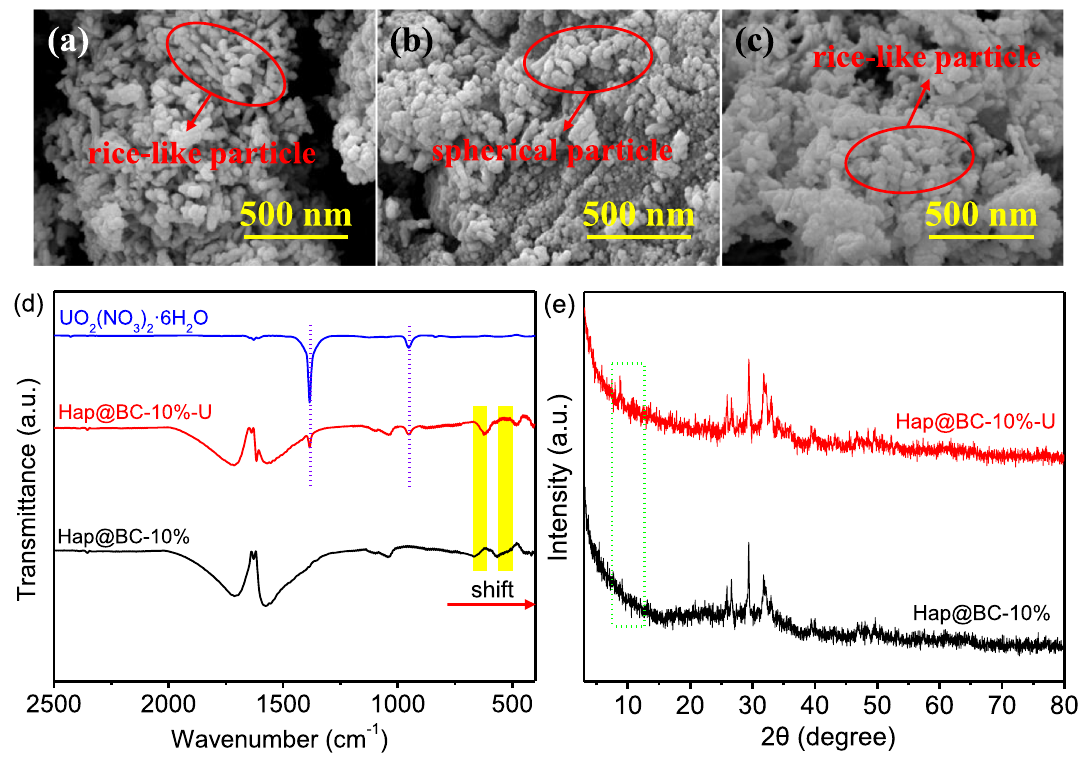
Fig. 8 a SEM image of Hap@BC-10%, b SEM image of Hap@BC-10%-U, c SEM image of Hap@BC-10%-U after desorption, d FT-IR spectra of Hap@BC-10%, Hap@BC-10%-U and UO 2 (NO 3 ) 2 ·H 2 O and e XRD patterns of Hap@BC-10% and